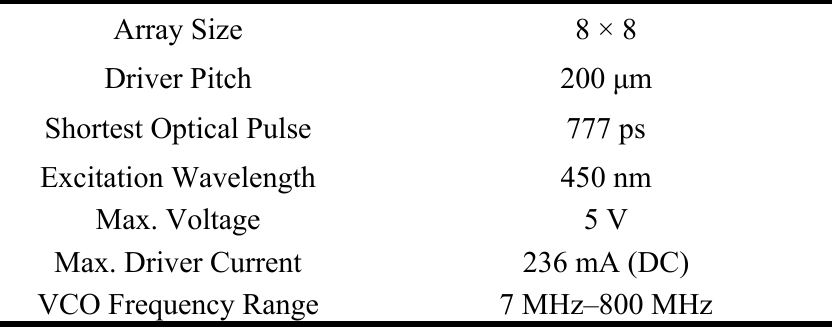
Table 1. Summary of Micro-LED Driver Array.